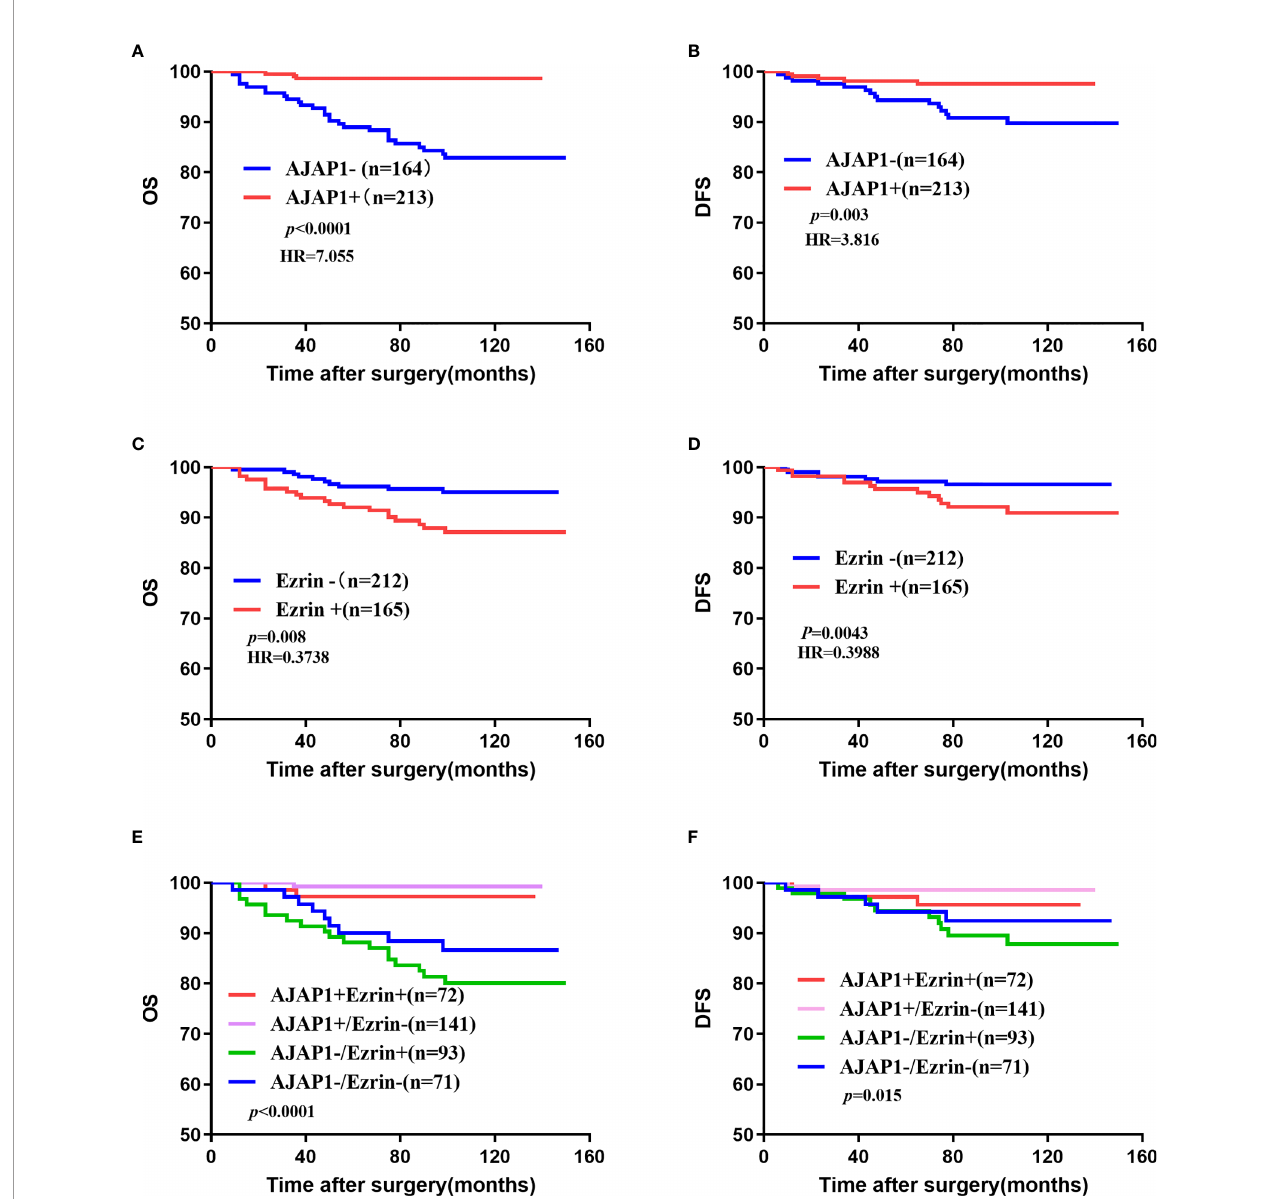
FIGURE 3 | Overall survival and disease-free survival of 377 cases of breast cancer. (A, B) OS (A) and DFS (B) of different AJAP1 expression. (C, D) OS (A) and DFS (B) of different Ezrin expression. (E, F) OS (E) and DFS (F) of different combination between AJAP1 and Ezrin